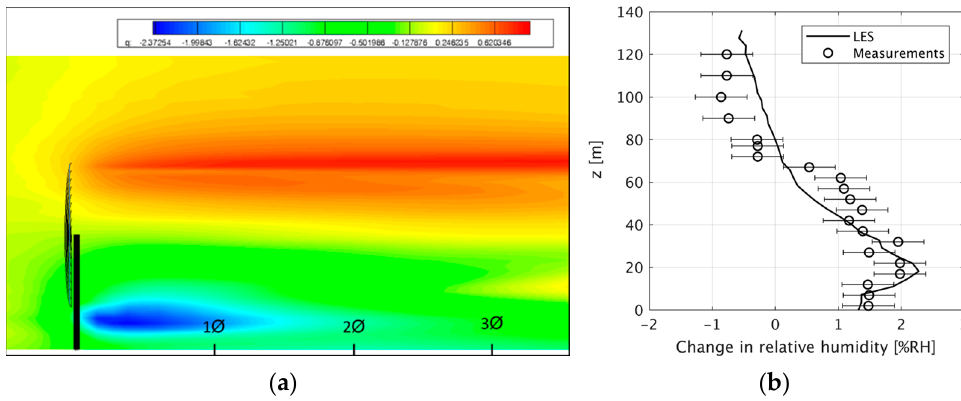
Figure 2. ( a ) Contour plots of time-averaged RH change in a vertical plane section passing through the hub and parallel to the streamwise direction; ( b ) LES time-averaged output and observed changes in RH, as a function of height (reprinted with permission from [36].